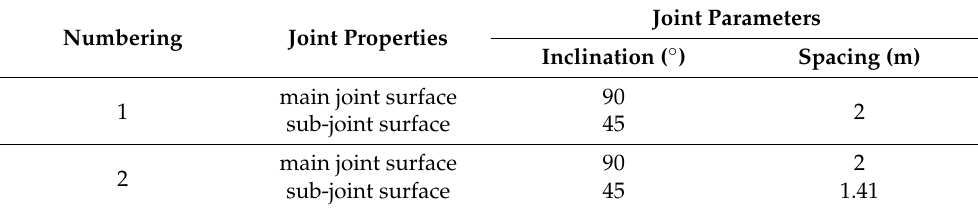
Figure 7. Model section of joint surfaces with different spacings in medium-hard coal seam. Table 7. Occurrences of joint surfaces with different spacings in medium-hard coal